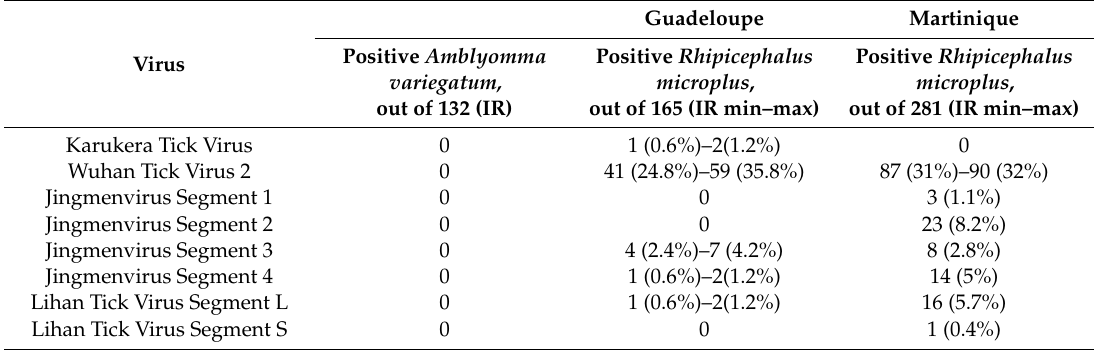
Table 4. Research of endogenous viral elements (EVE) in ticks collected in Guadeloupe and Martinique. Numberofpositiveticks Amblyommavariegatum (outofthe132), Rhipicephalusmicroplus fromGuadeloupe (out of 165) and Martinique (out of 281). As some samples of Rhipicephalus (B.) microplus were pooled, we present minimum and maximum infection rates of infected